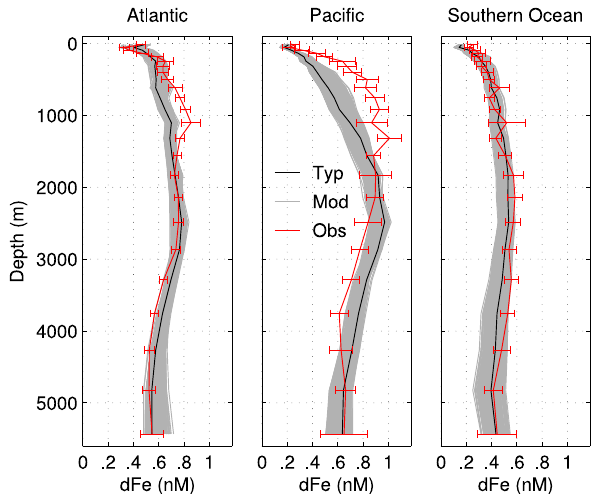
Figure 3. Basin-wide, cost-weighted average profiles of the (red) observed and (grey) modeled dFe concentrations for the Atlantic and Pacific oceans (both north of 40 ◦ S), and the Southern Ocean (south of 40 ◦ S). The profiles of our typical state estimate are shown in black. The error bars represent the combined standard error as- sociated with the spatial standard deviation from the basin-mean profile and the observational standard deviation for each grid box. These were added in weighted quadrature using the weights for dFe mismatch from our cost